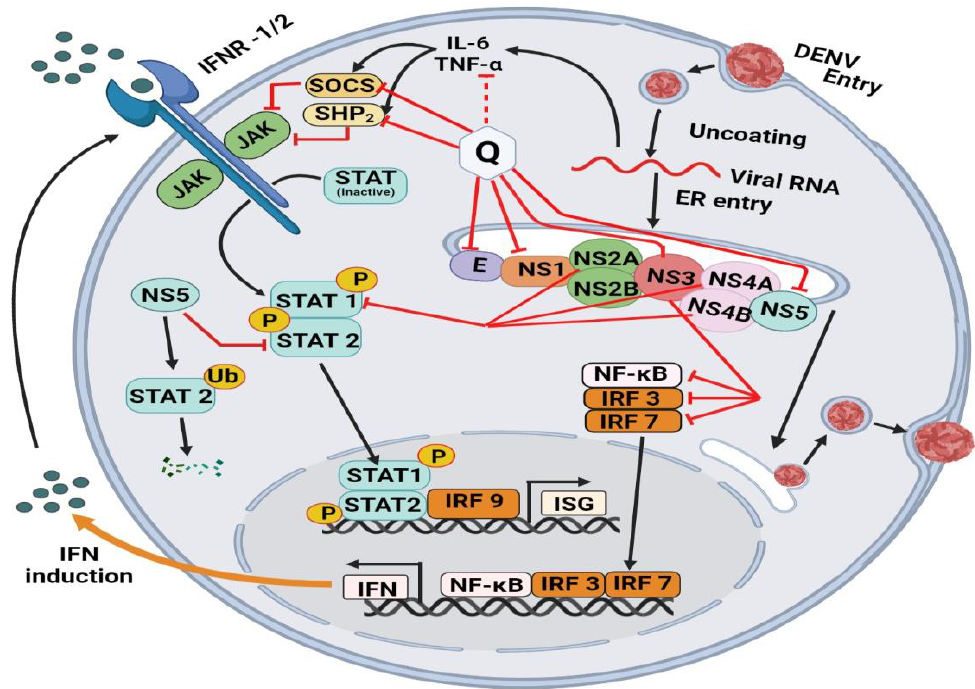
Figure 4. Effects of Quercetin in redirecting the virulence-mechanism of dengue virus. Ejection of Dengue virus particles from the cellular system with the involvement of cascade molecules, such as JAK, KFKB, STAT 1, STAT 2, NS2A, NS2B, SOCS, and SHP. The mechanism is assisted by the direct effect of Quercetin on the inhibition of the NF-kB pathway, which induces the production of a number of inflammatory and proinflammatory molecules. Interferon regulatory factors IFN, IRF3, and IRF7 are concomitantly reduced. The indirect effect of Quercetin is mediated by the inhibitory cascade of tumor necrosis factor, which affects the synthesis of IL6 and eventually leads to the restoration of Janus kinase (JAK)-signal transducer and activator of the transcription (STAT)